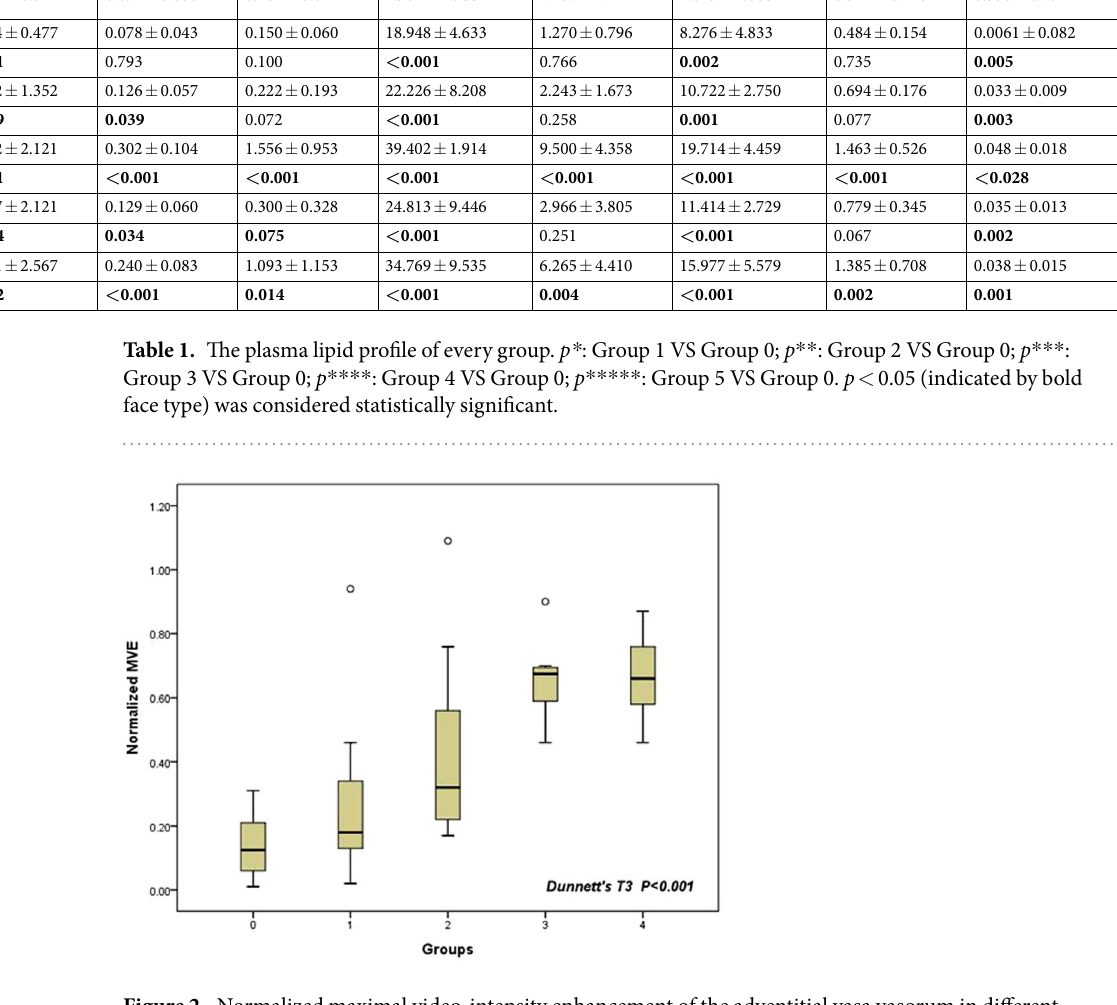
VEGF in Fig. 5B,E and H, and the positive microvessels of CD31 in Fig. 5C,F and I are highlighted by small red arrows. It is obvious that the number of VEGF-positive and CD31-positive microvessels increased with the pro- gression of atherosclerosis.